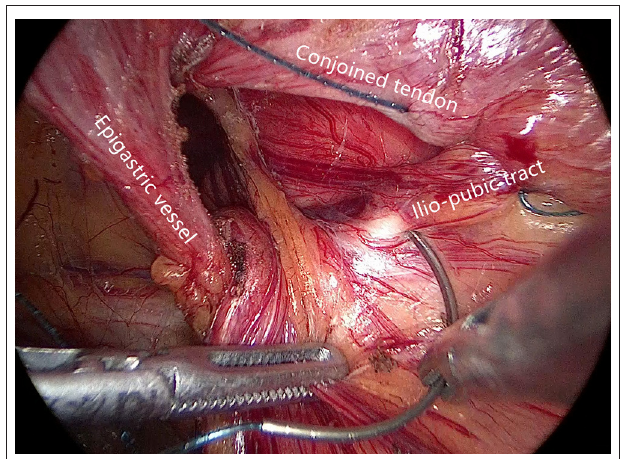
FIGURE 5 | The fifth stitch.